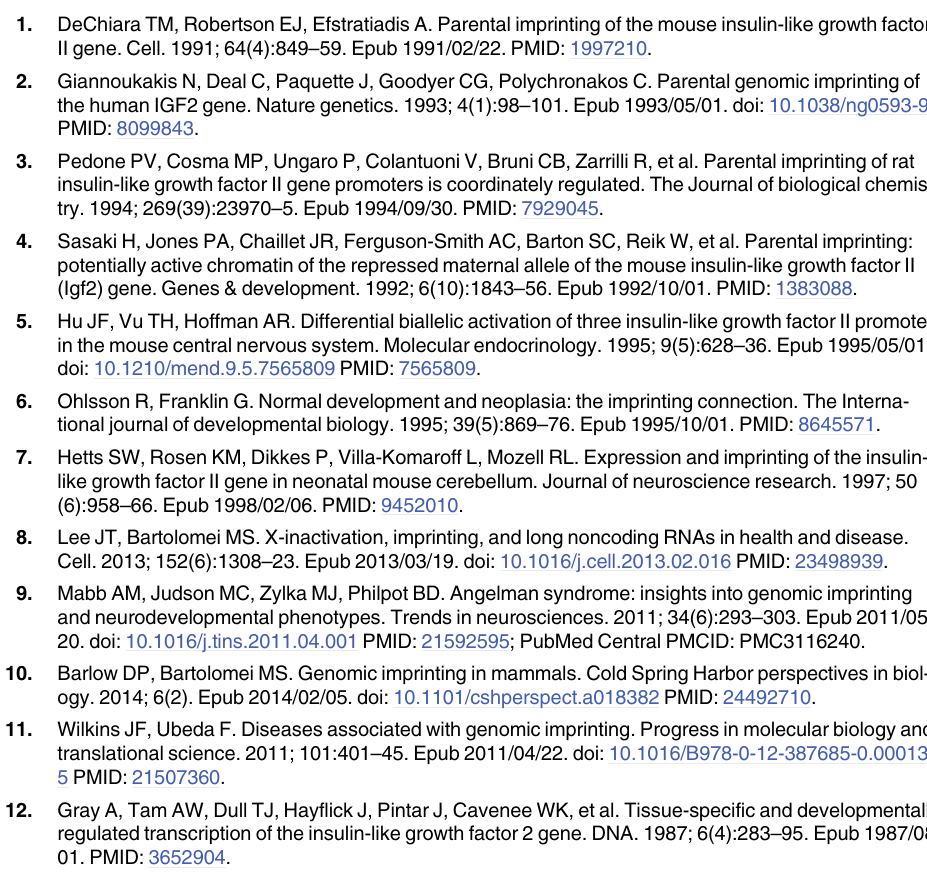
Fig 4. Inhibitory avoidance training results in an increase of Igf2 mRNA levels in the dHC, ACC, and PrL/IL from both parental alleles at 20hr post- training. Adult male F1 rats were trained in IA, and 20hrs later, brains were collected from both trained (Tr) rats and control na ï ve (N) rats. Quantitative real- time PCR was used to analyze the total, paternal (Pat.) and maternal (Mat.) Igf2 mRNA levels in the dHC (A, n = 6 – 7; for total Igf2 : t 11 = 2.96, P = 0.013; for paternal Igf2 : t 11 = 4.31, P = 0.0012; for maternal Igf2 : t 11 = 4.12, P = 0.0017), ACC (B, n = 7 – 9; for total Igf2 : t 14 = 2.54, P = 0.0235; for paternal Igf2 : t 14 = 2.87, P = 0.0124; for maternal Igf2 : t 14 = 4.44, P = 0.0006), PrL/IL (C, n = 7; for total Igf2 : t 12 = 2.28, P = 0.04; for paternal Igf2 : t 12 = 2.77, P = 0.017; for maternal Igf2 : t 12 = 2.02, P = 0.066) and BLA (D, n = 6 – 7; for total Igf2 : t 11 = 0.07, P = 0.94; for paternal Igf2 : t 11 = 1.15, P = 0.27; for maternal Igf2 : t 11 = 0.23, P = 0.82). Igf2 mRNA level in each sample was normalized to that of the 18S RNA level. Data are presented as mean ± SEM of the ratio of Igf2 levels in the brain regions taken from trained to na ï ve rats. Schematic representations of the % expression of Igf2 mRNA from the paternal or maternal allele in each tissue analyzed. * P < 0.05, ** P < 0.01, *** P < 0.001. (E) Analysis of the CpG methylation levels by methylation-sensitive pyrosequencing in Igf2 /H-19 imprinting control region (ICR), differentially methylation region 2 (DMR2) and P2 promoter of Igf2 gene in liver, CP, dHC and ACC, as well as in dHC and ACC from na ï ve (N) versus trained (Tr) rats. Data are presented as the mean ± SEM of the percentage of methylation across 15 CpG sites in the ICR region (F (5, 84) = 1.18, P = 0.33), 19 CpG sites in the DMR2 region (F (5, 108) = 6.28, P < 0.0001), and 11 CpG sites in the P2 region (F (5, 60) = 8.71, P < 0.0001). *** P <